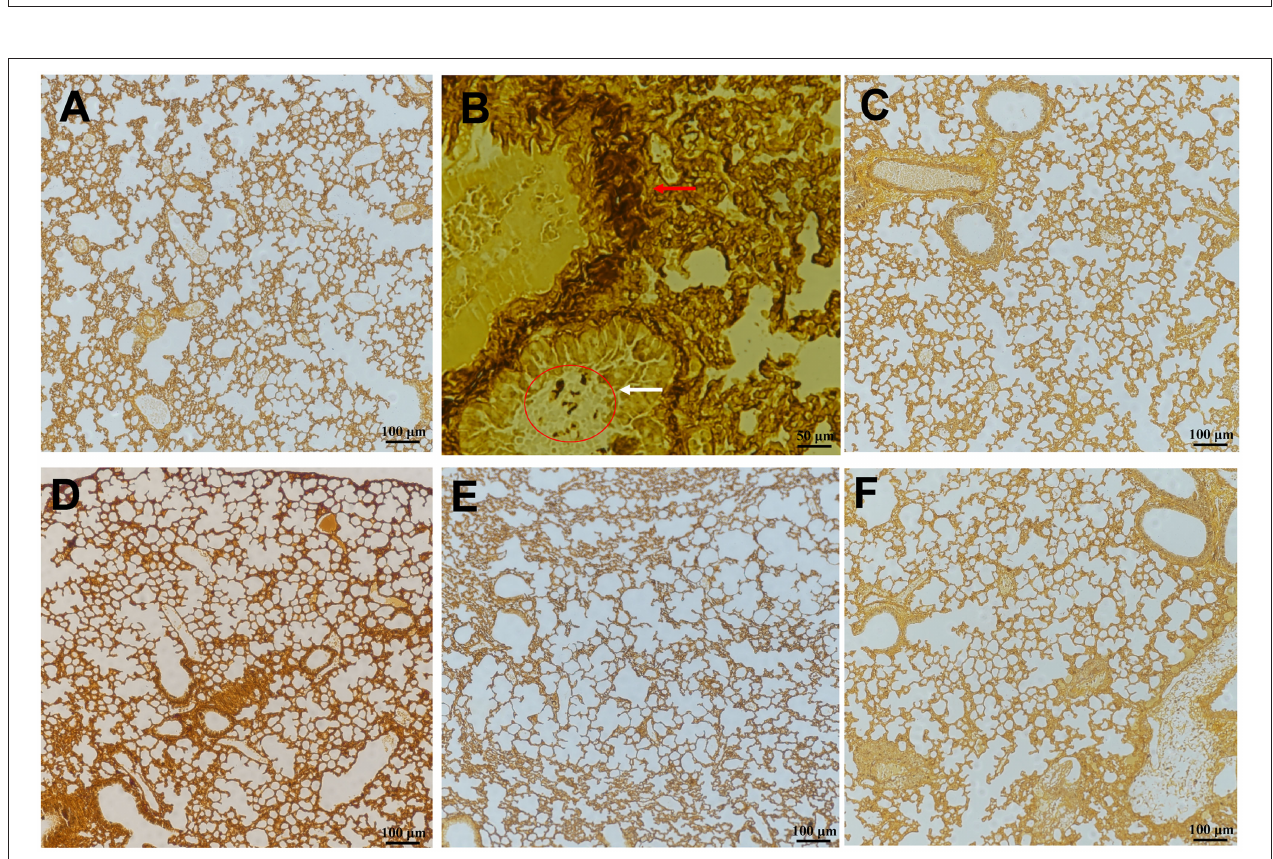
FIGURE 7 | Representative PASM-stained sections of the lungs of mice in various groups after treatment. (A) Normal lung section ( × 200, mice without infection). (B) Lung section of C. albicans -infected mice treated with water showed numerous intracellular and extracellular, round, oval or elongate, elongated, and moniliform hyphal C. albicans (red arrows, × 400). (C) Lung section of mice treated with FLC (1.5 mg/kg/d) showed similar findings to uninfected mice ( × 200). (D) Lung section of mice treated with low dosage of SAN (0.5 mg/kg/d), middle dosage of SAN [ (E) , 1.5 mg/kg/d], and high dosage of SAN [ (F) , 2.5 mg/kg/d] after PASM staining showed significantly reduced the amount of fungi ( ×